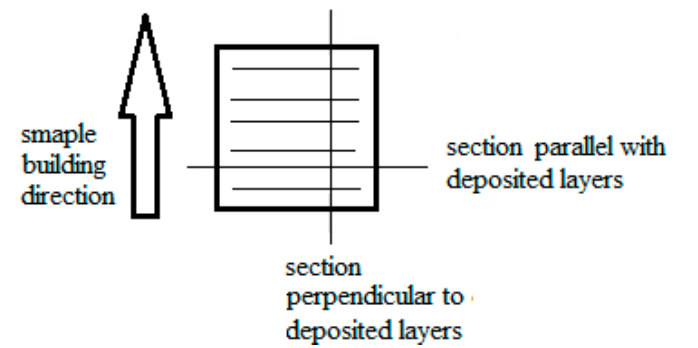
Figure 3. Way of material collection for metallographic observation.